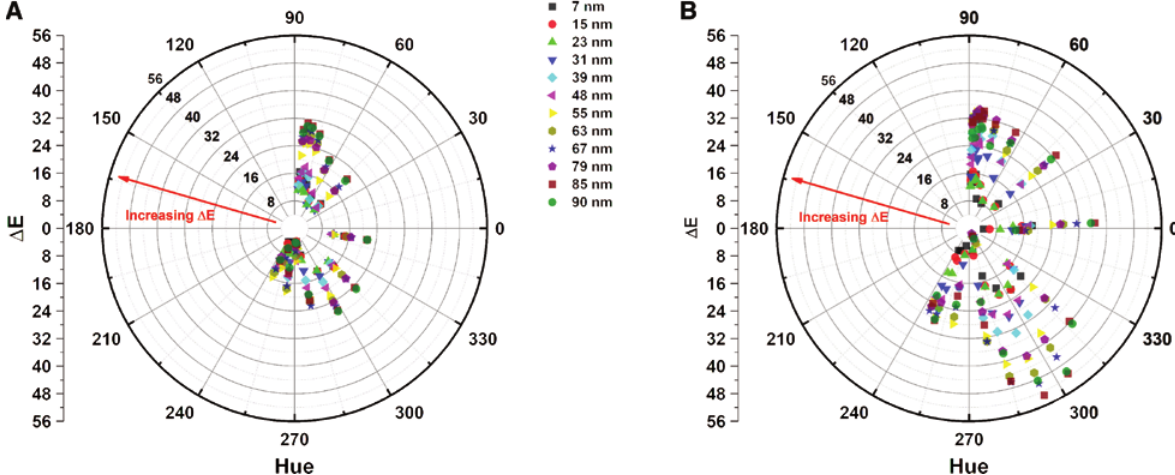
Figure 11: Colourimetric sensing response of the coloured surfaces. Polar plot of the change in colour (i.e. Δ E ) versus hue for the (A) nonburst and (B) burst colours with increasing alumina thickness. The change in colour, Δ E , increases radially outward as represented by the red arrow. The change in colour with alumina thickness is observed to be dependent on the initial hue